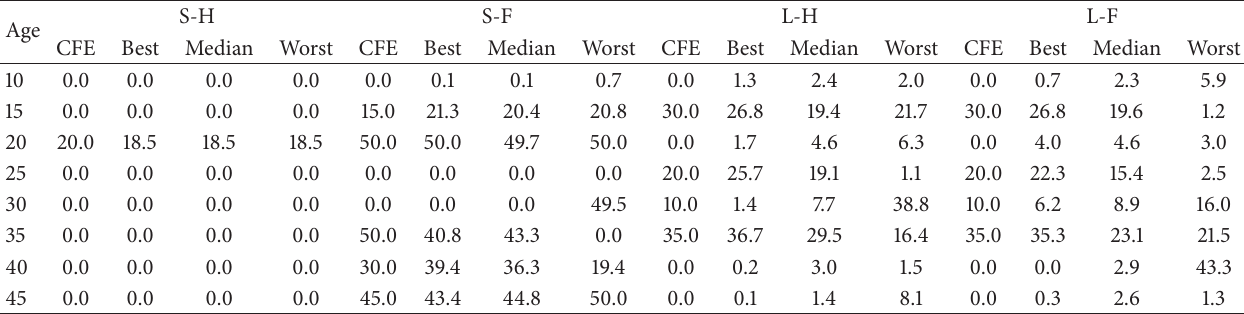
Table 4: Optimized thinning rates (%) provided by CFE and